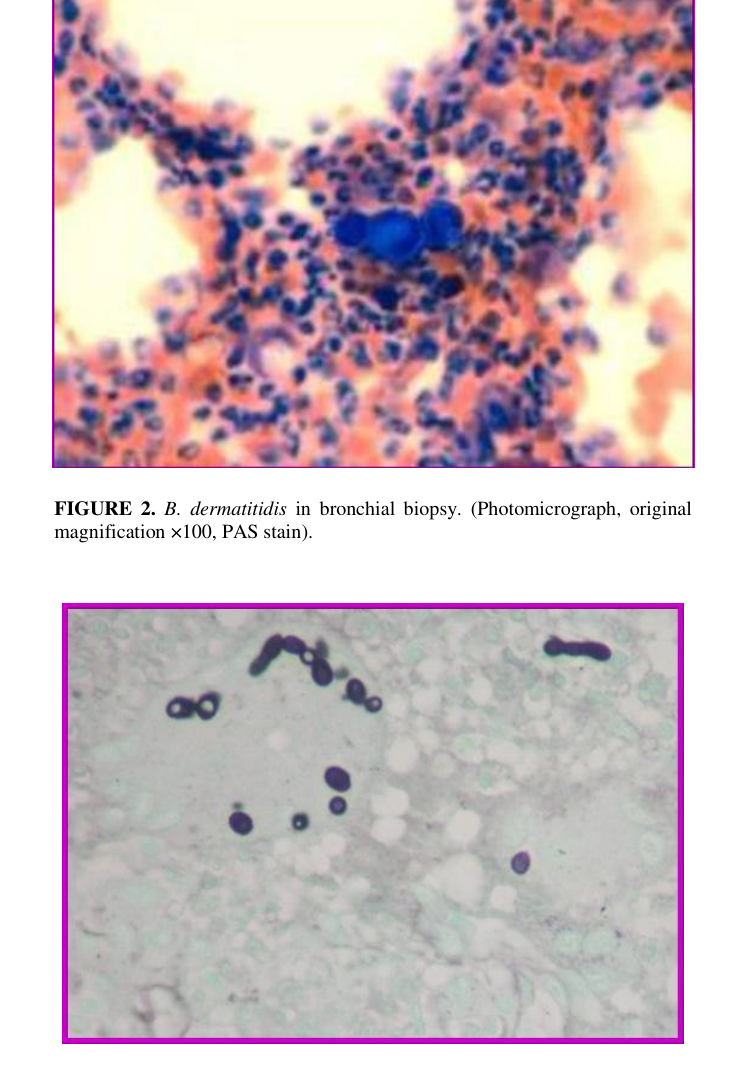
FIGURE 3. Bronchial biopsy. Photomicrograph (original magnification ×100; Gomori methenamine silver stain) shows reproducing B. dermatitidis cells, with broad-based budding and large daughter